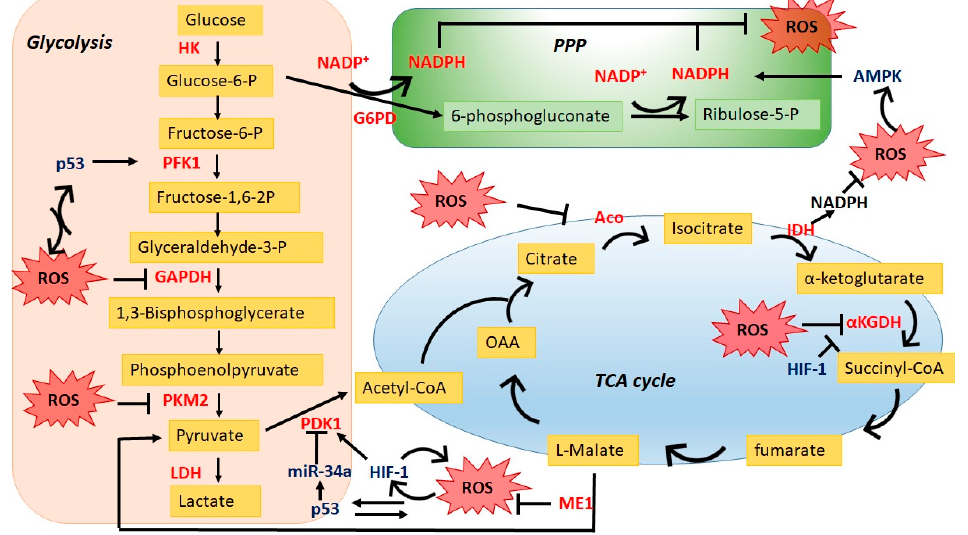
Figure 1. Interplay between reactive oxygen species (ROS) and the central carbon metabolism. ROS impact cellular metabolism through regulating key enzymes in glycolysis pathway/TCA cycle as well as redox signaling pathways; reciprocally, energy metabolic pathways especially PPP balance ROS homeostasis in cancer cells. PPP, pentose phosphate pathway; HK, hexokinase; PFK1, phosphofructokinase 1; PDK1, pyruvate dehydrogenase kinase; G6PD, glucose 6-phosphate dehydrogenase; Aco, aconitase; α KGDH, Alpha ketoglutarate dehydrogenase; IDH, isocitrate dehydrogenase; ME1, malic enzyme